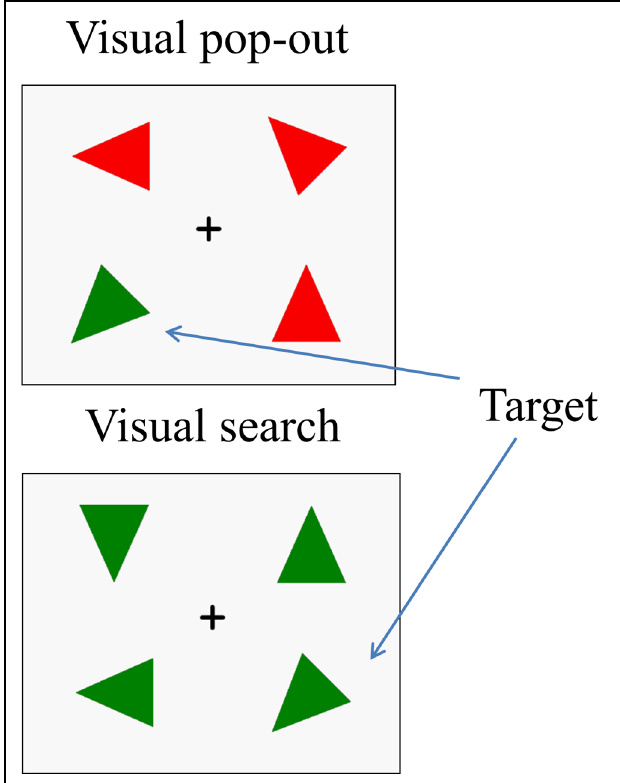
FIGURE 1 | An example of the stimulus array in the two experimental conditions. Each trial includes a target. In the (up panel) , the distractors differ from the target in both color and orientation, so that target detection is highly efficient and easy. In this pop-out condition, search is influenced primarily by the bottom–up attention. In the (down panel) , the distractors differ from the target only in orientation, so that target detection is less efficient and difficult. In this search condition, target detection is controlled mainly by top–down